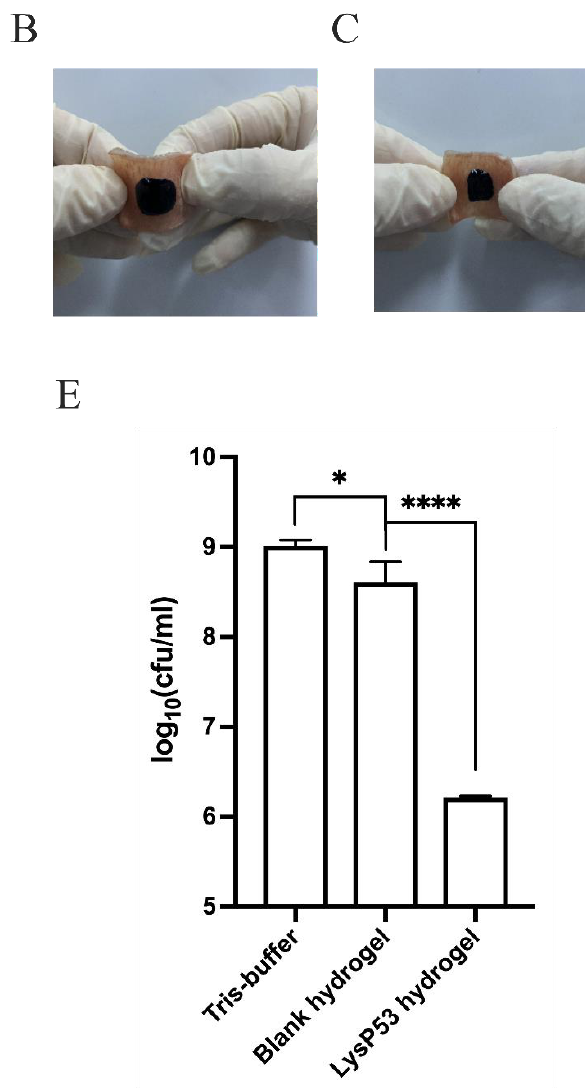
Figure 5. Photographs of the stretching ( A ), bending ( B ), compressing ( C ), and twisting ( D ) processes of LysP53 hydrogel. ( E ) A. baumannii concentrations were lower in the pig skin infection model treated with LysP53 hydrogel than those treated with Tris-buffer and blank hydrogel for 24 h (* <0.05, **** <0.0001).